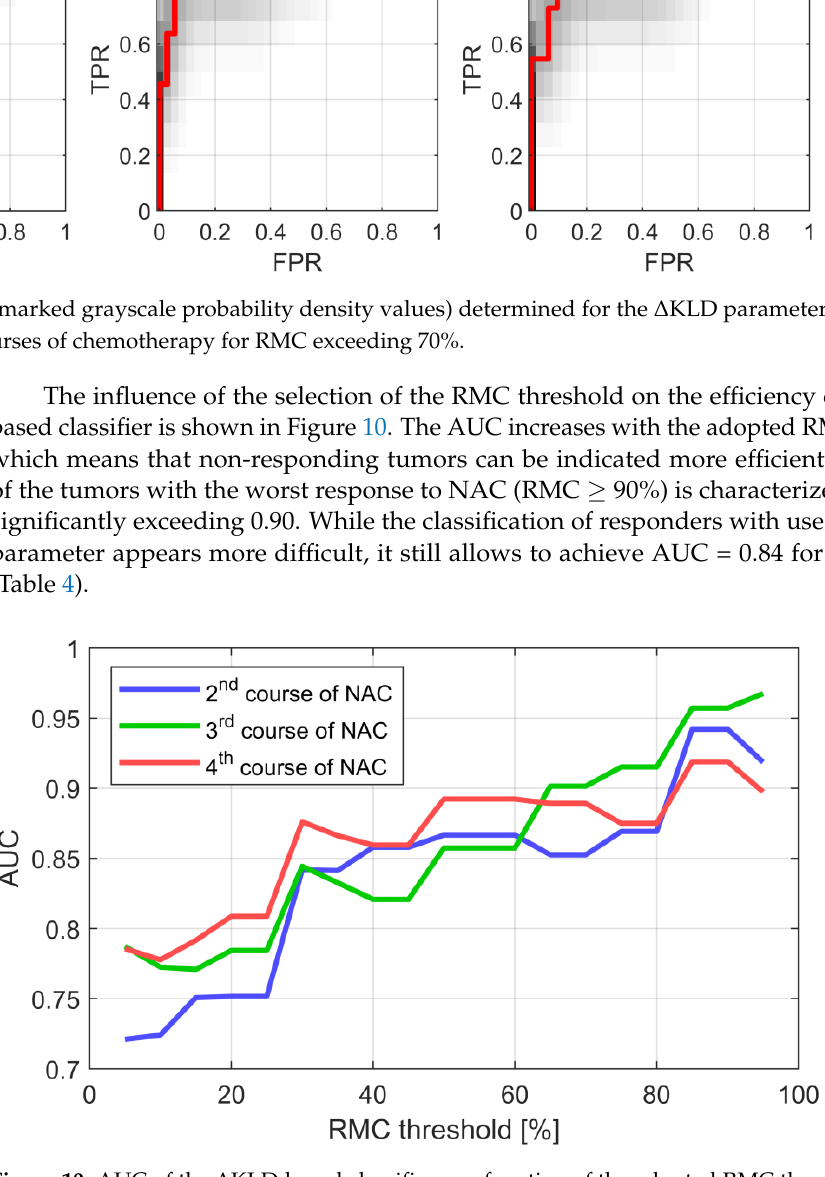
Figure 10. AUC of the ΔKLD -based classifier as a function of the adopted RMC threshold level.